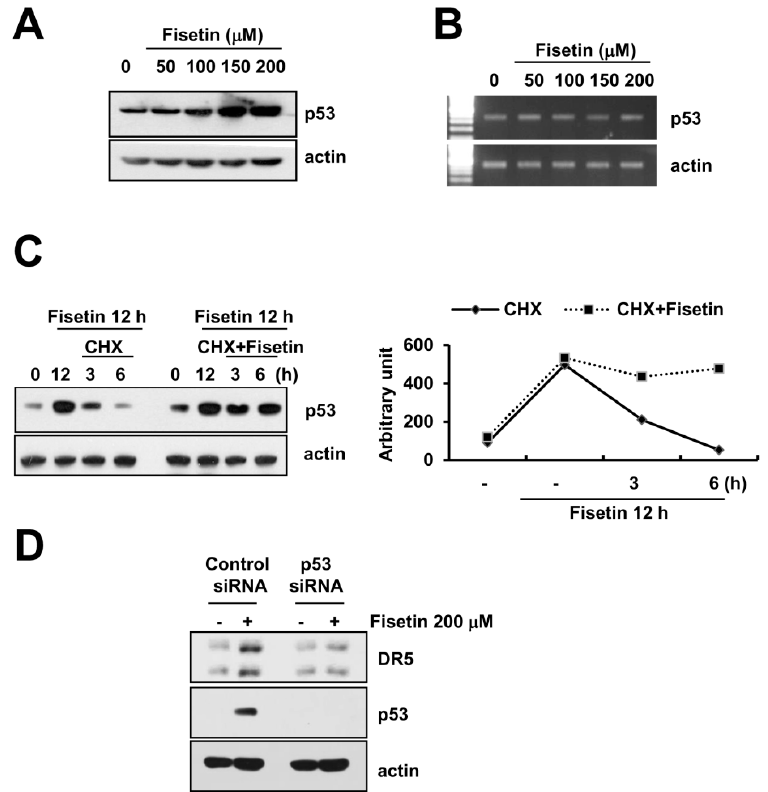
Figure 5. Fisetin induced DR5 expression via up-regulation of p53 expression at the post-translational levels. ( A , B ) Caki cells were treated with the indicated concentrations of fisetin for 24 h. p53 and actin protein and mRNA expression were determined by western blotting and RT-PCR, respectively; ( C ) Caki cells were treated with 200 μ M fisetin for 12 h, and then washed twice with PBS. After washing, cells were treated with or without 200 μ M fisetin in the presence of cyclohexamide (CHX) (20 μ g/mL) for the indicated time periods. p53 and actin protein expression were determined by western blotting; the band intensities of p53 protein were measured using the public domain JAVA image-processing program ImageJ ( D ) Caki cells were transfected with control or p53 siRNA. Twenty-four hours after transfection, cells were treated with 200 μ M fisetin for 24 h. The protein expression levels of p53, DR5, and actin were determined by western blotting. The level of actin was used as a loading control.